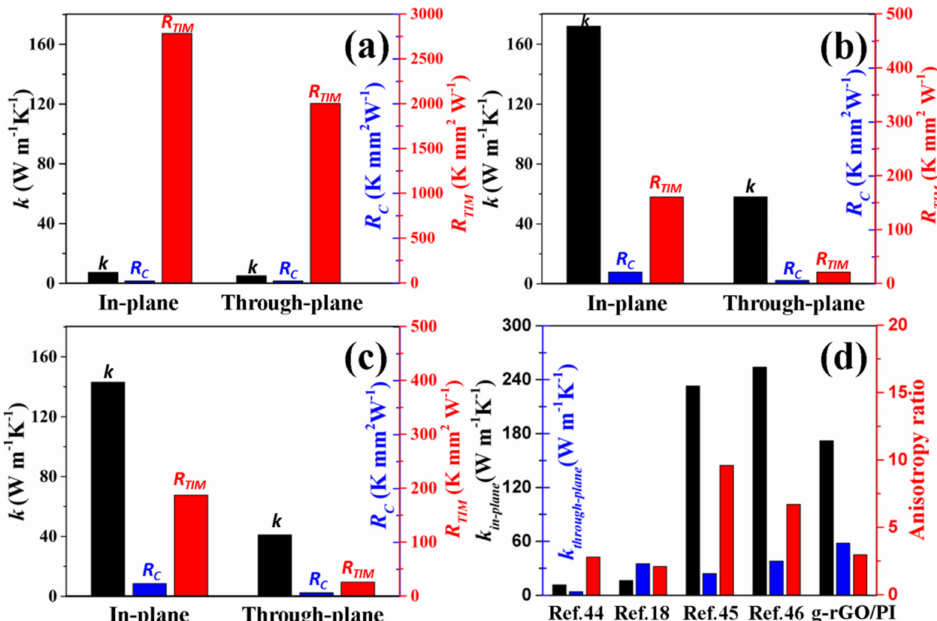
Figure 7. Thermal transport performances of ( a ) g-rGO/PI aerogel without compression, ( b ) g- rGO/PI aerogel at 95% compressive strain and ( c ) g-rGO aerogel at 95% compressive strain; ( d ) Comparison of thermal transport performances between the carbon-based TIMs in previous reports and the compacted g-rGO/PI